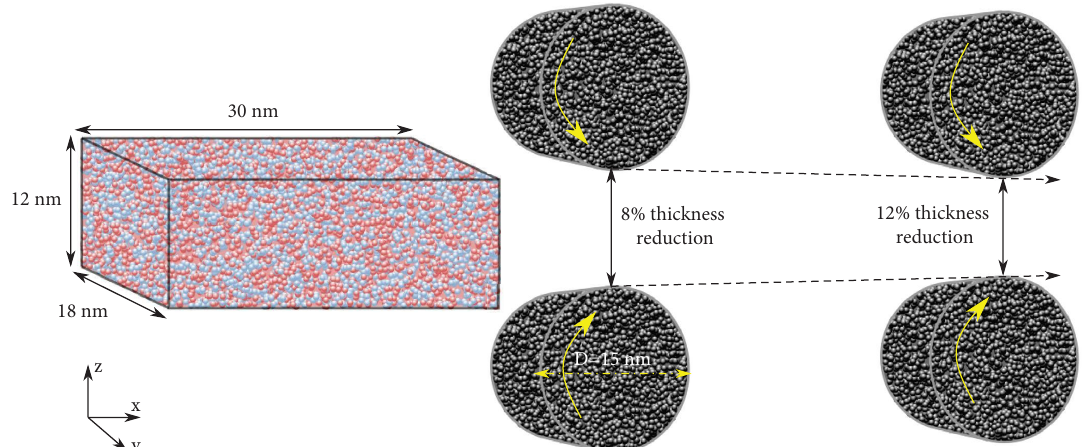
Figure 1: Schematic of rolling process for CuZr MG plate.